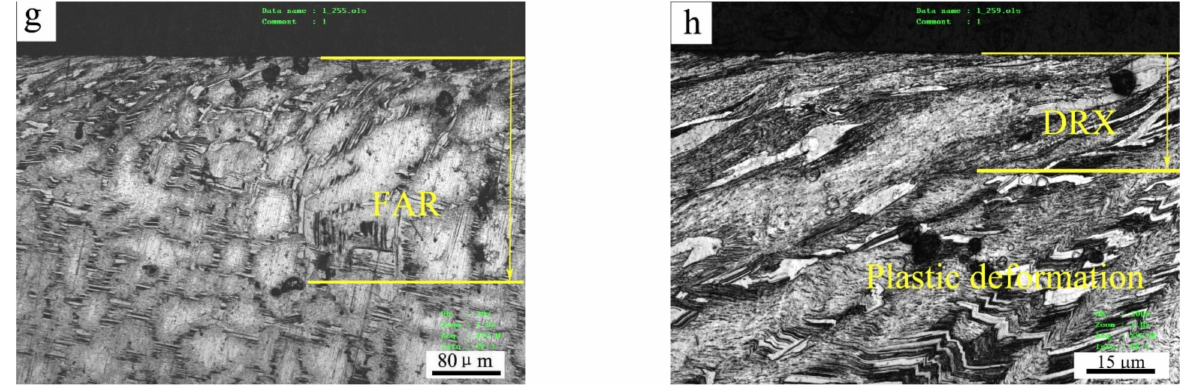
Figure 6. Optical images of cross-sectional microstructures at 100 ◦ C ( a – d ) and 200 ◦ C ( e – h ) under different loads: ( a ) and ( b ) 60 N, ( c ) and ( d ) 80 N, ( e ) and ( f ) 20N, ( g ) and ( h ) 40 N.